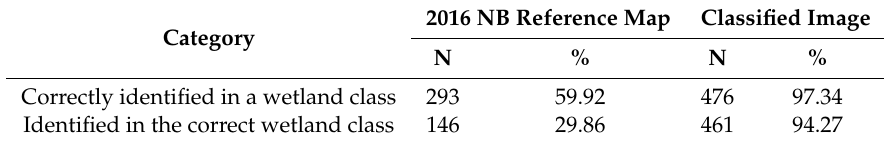
Table 13. Comparison between the NB wetland map and the classified image for the number or percentage of the 489 in-situ validation GPS wetland sites that were correctly identified in a wetland class or in the correct wetland class.